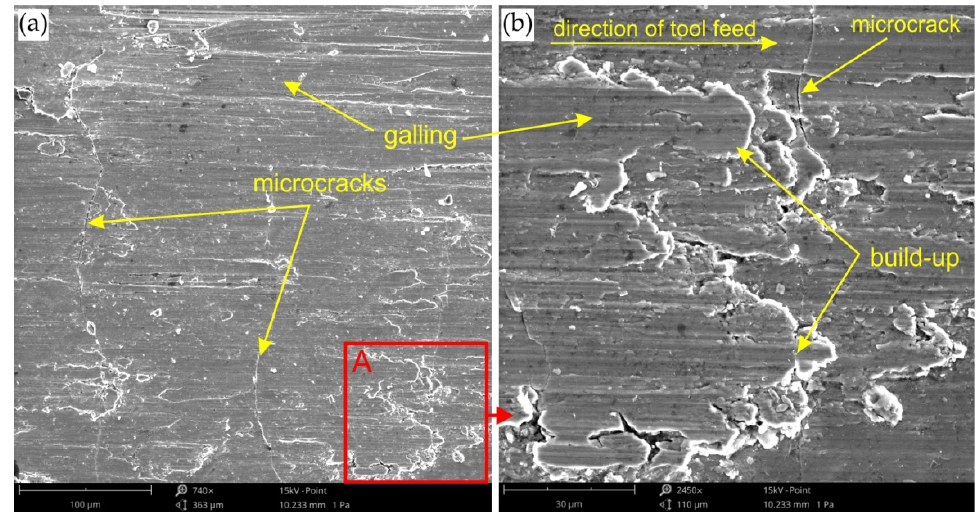
Figure 8. Topography of inside surface of the drawpieces formed at a p = 0.5 mm, f = 500 mm/min, n = 600 rpm and toolpath strategy: ( a ) conventional and ( b ) climb.